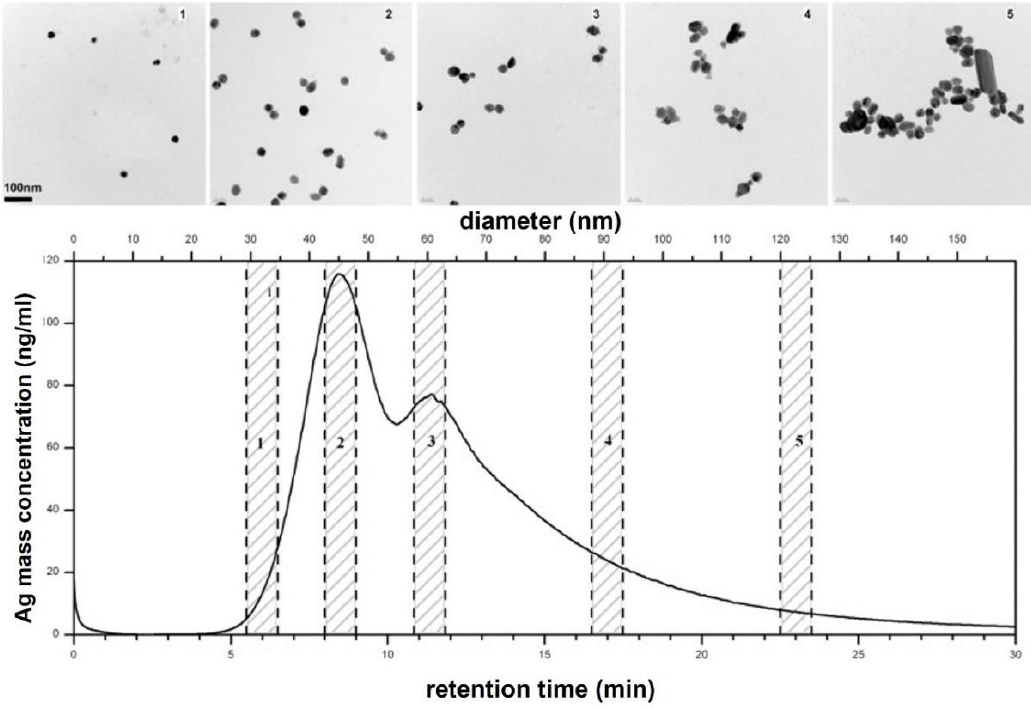
Figure 3. TEM images corresponding to collected fractions of AgNPs separated by AF4 at the conditions: m inj = 10 µg, carrier liquid (NH 4 ) 2 CO 3 at pH 9, channel and cross flow rate 1.0 mL/min, spacer height 350 µm, PES membrane. Reprinted from [27] copyright (2013), with permission from Elsevier.